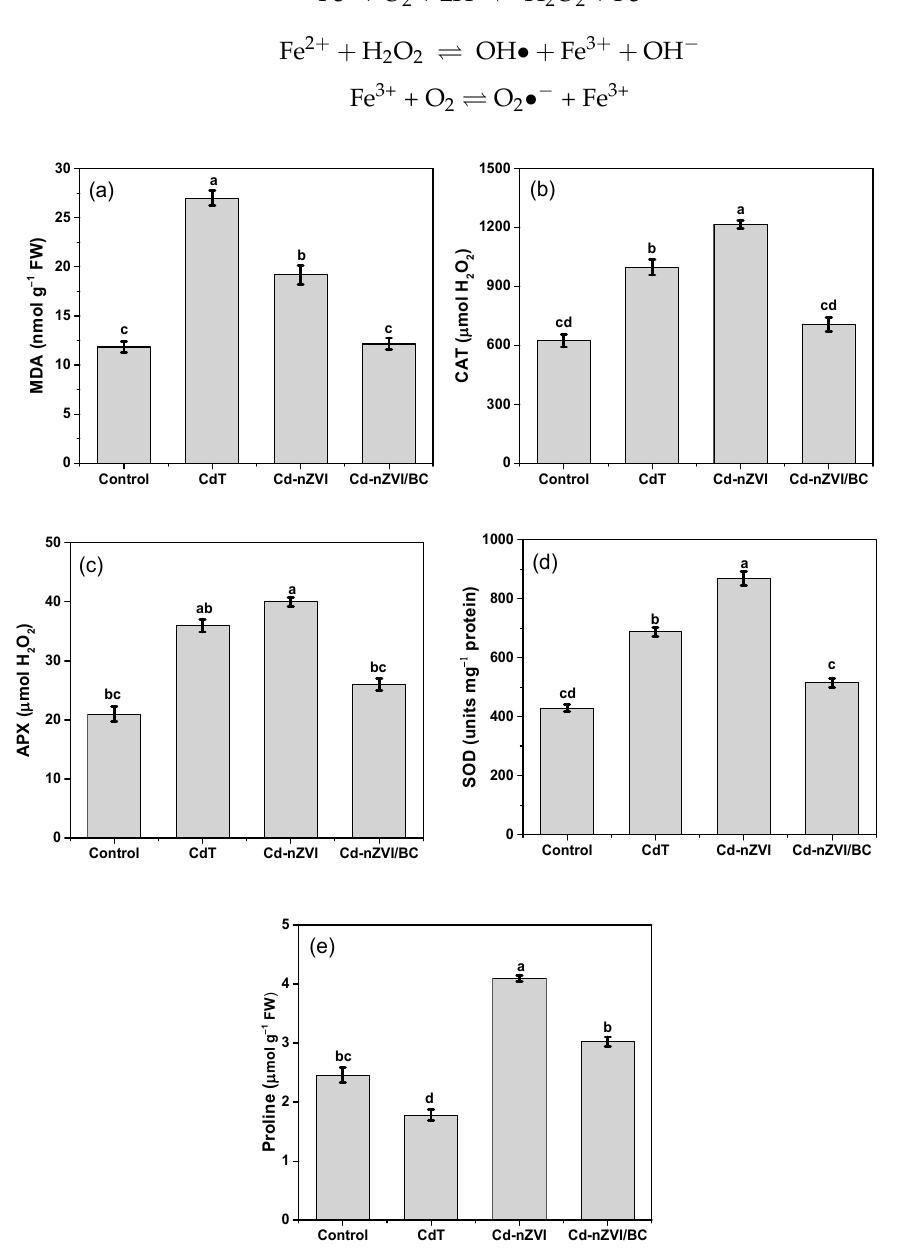
Figure 6. Impact of nZVI and nZVI/BC application on lipid peroxidation, enzymatic and non- enzymatic activities, ( a ) MDA contents; ( b ) catalase activity; ( c ) ascorbate peroxidase activity; ( d ) su- peroxide dismutase activity; and ( e ) proline modulation. Bars not sharing the same lower-case letter are significantly different (Tukey’s HSD α < 0.05). Represented data are the mean ( n = 6) with ± standard deviation.